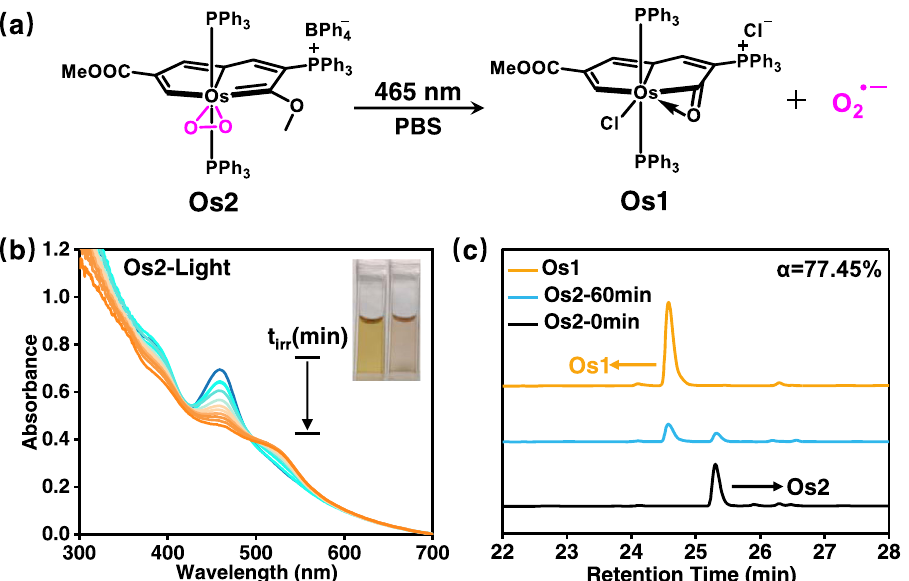
Fig. 1 Photoactivation of Os2. a Schematic diagram of light-mediated Os2 release of O 2 (cid:129) − and Os1 . b The UV – Vis absorption spectra of Os2 (100 μ M) in PBS solution (pH = 7.4, 1% DMSO) under light illumination (465 nm, 13 mW/cm 2 ) at 298 K. c HPLC analysis of Os2 (10 μ M) in PBS solution (1% DMSO) in the dark or after irradiating for 60 min. Mobile phase was CH 3 CN and water (v/v 1:1).